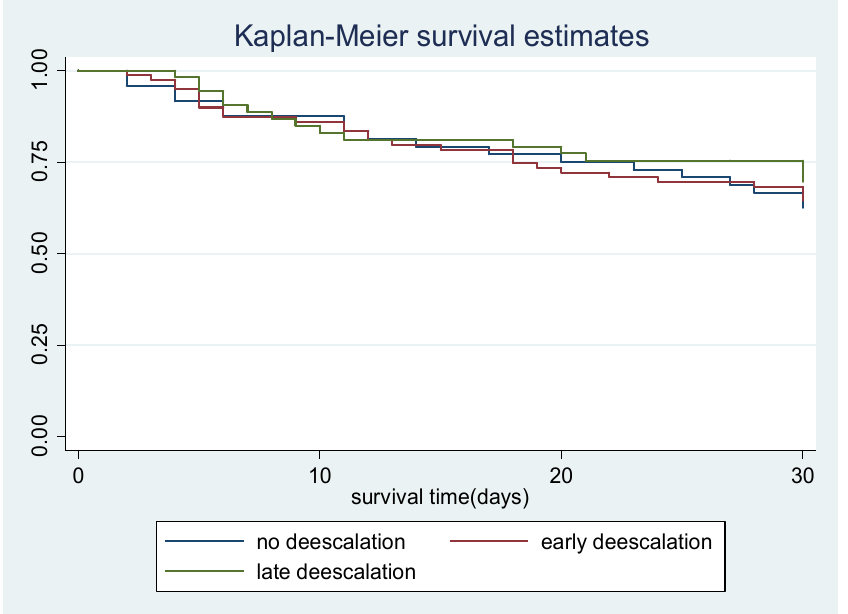
Figure 1. Kaplan-Meier estimates for overall survival rates based on de-escalation group; no de- escalation, early de-escalation and late de-escalation.